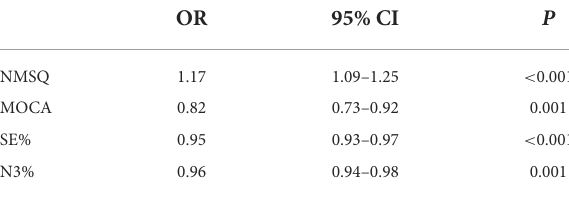
TABLE 5 Logistic regression analyses for independent predictors of hallucinations in Parkinson’s disease patients.